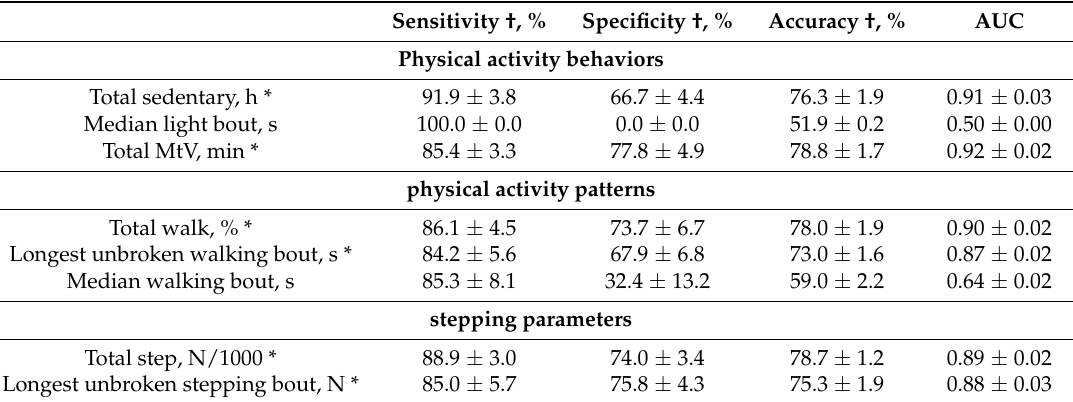
Table 3. The performance of each parameter to discriminate the pre-frail group from the non-frail and frail